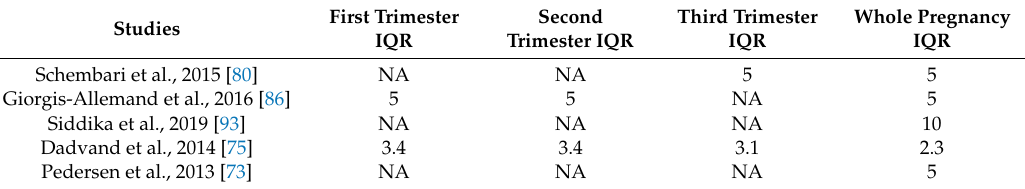
Table A8. IQR table for PM 2.5 exposure ( µ g / m 3